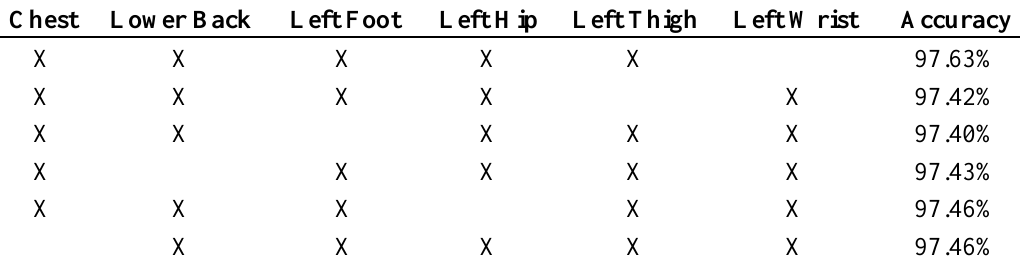
Table 9. Percentage Correctly Classified Instances for 5 location combinations. Chest